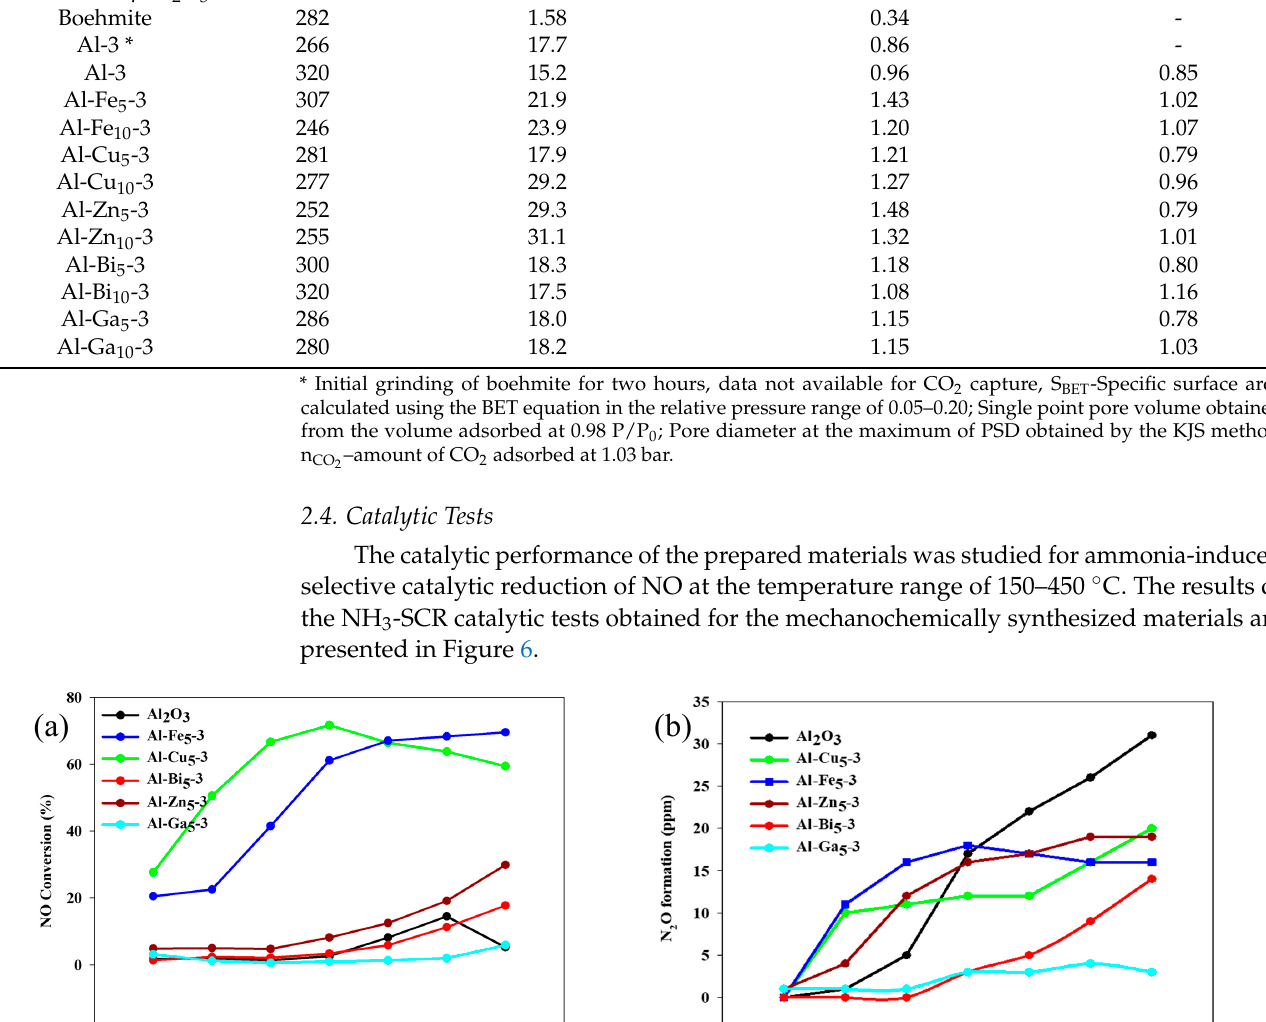
Table 2. Textural properties of the synthesized samples.